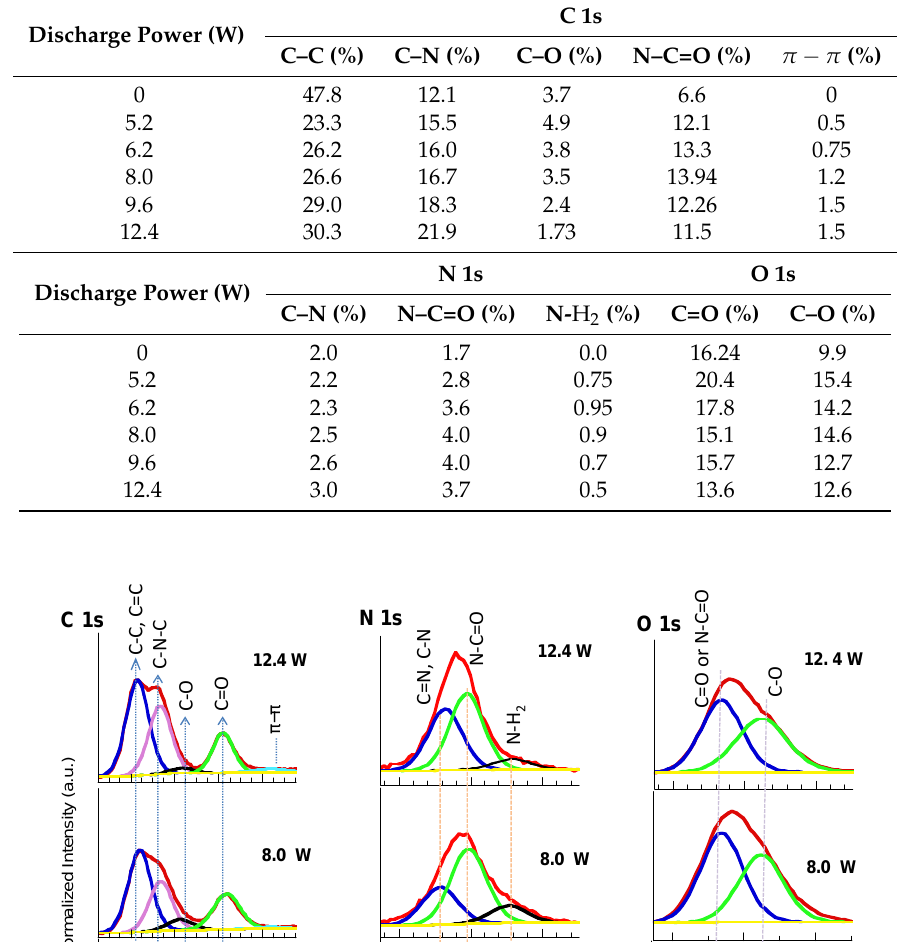
Table 2. Relative percentage of functional groups composed of high resolution C 1s, N 1s, and O 1s spectra of the pristine and plasma-treated polyimide as a function of discharge power. Same discharge conditions as Table 1.